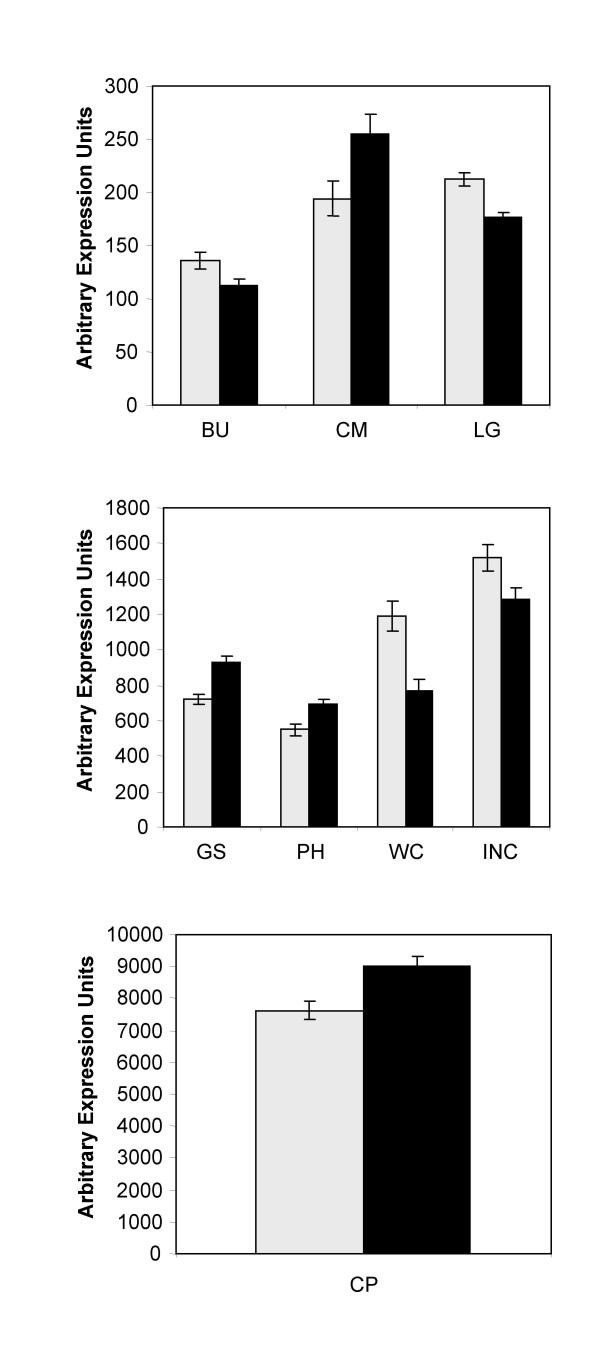
Network level variation between Bay-0 and Sha. The eight networks showing significantly differential expression between Arabidopsis thaliana accessions Bay-0 and Sha at P = 0.05 using Tukey's HSD are illustrated. Network abbreviations are as described in Table 1. Black bars show the average network expression value for Sha while light grey is for Bay-0. Networks not shown did not show a statistically significant difference in the eight Affymetrix ATH1 GeneChips utilized (four Bay-0 and four Sha).